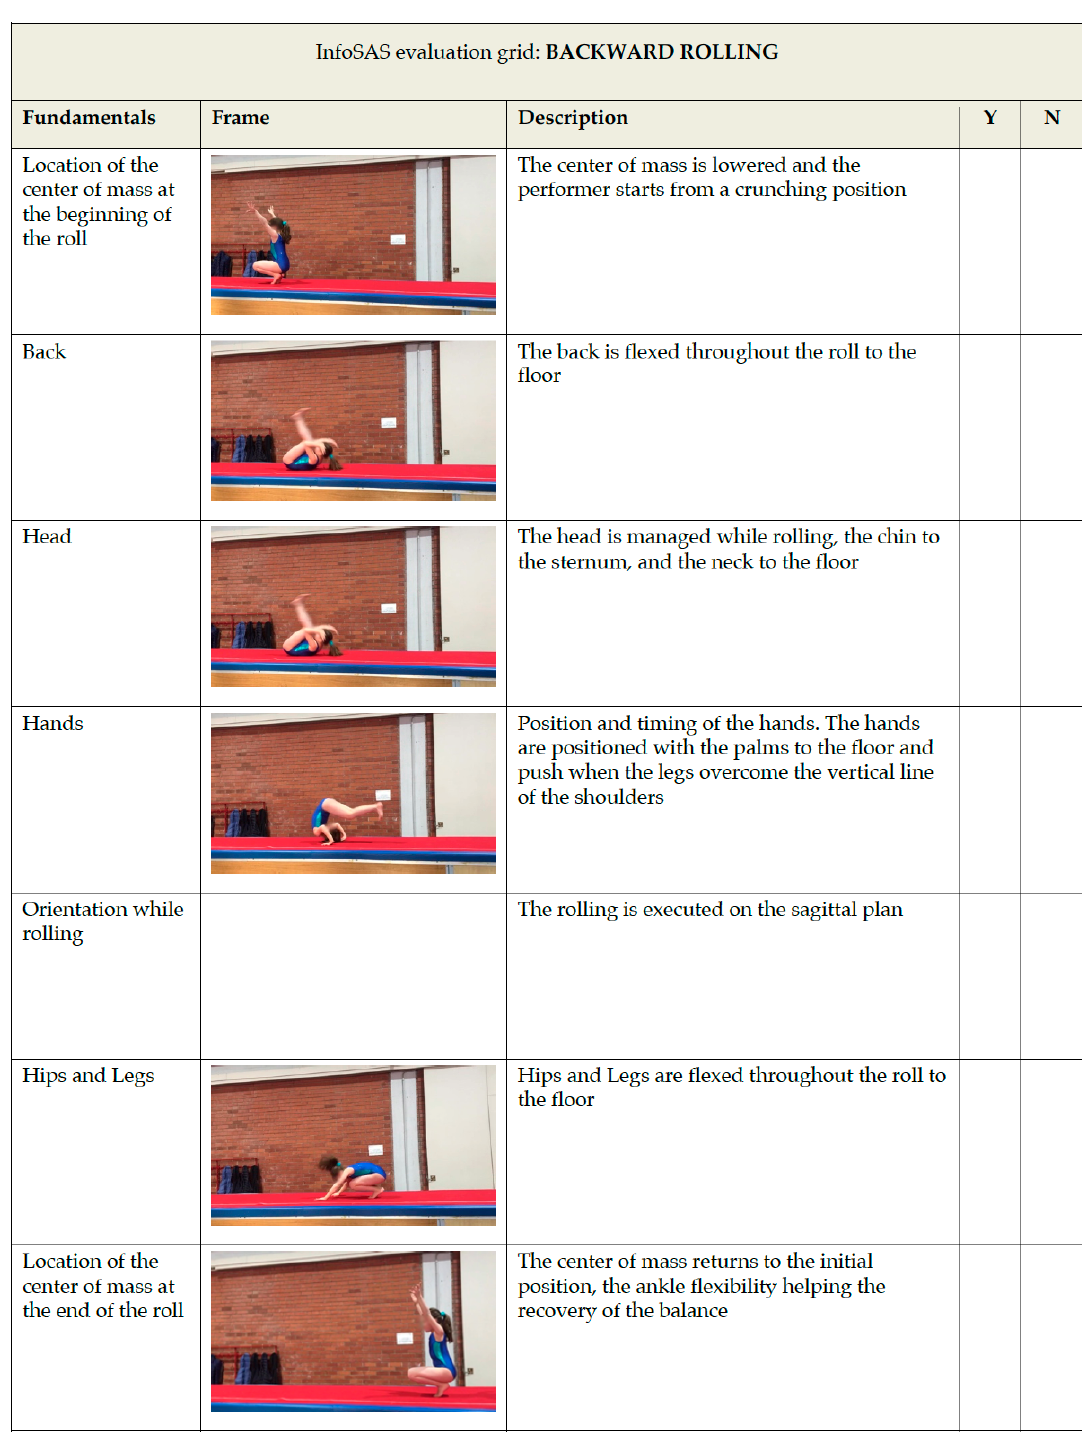
Figure A4. InfoSAS evaluation grid for backward rolling rating.